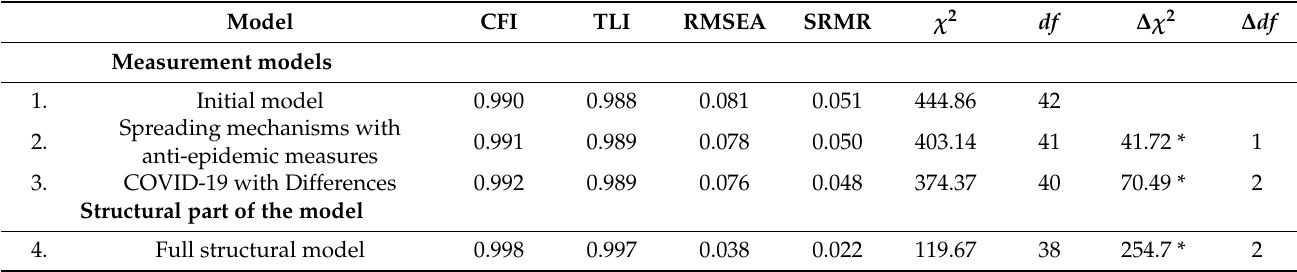
Table 4. A step-wise measurement model comparison procedure and an evaluation of the structural part of the SR